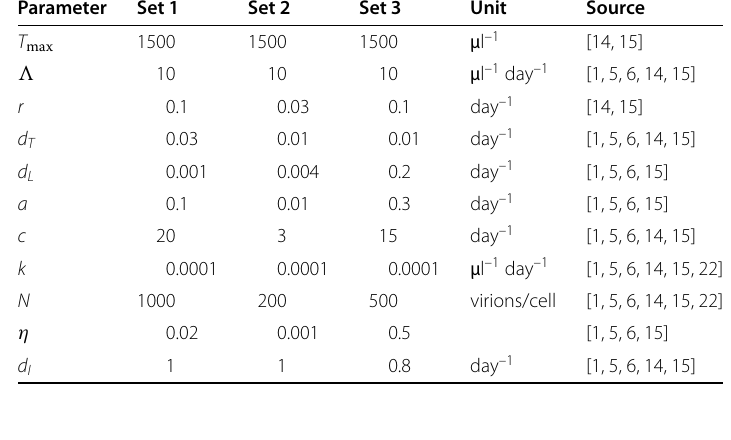
Table 10 Parameter values (adapted from Wang et al. [15]) Parameter